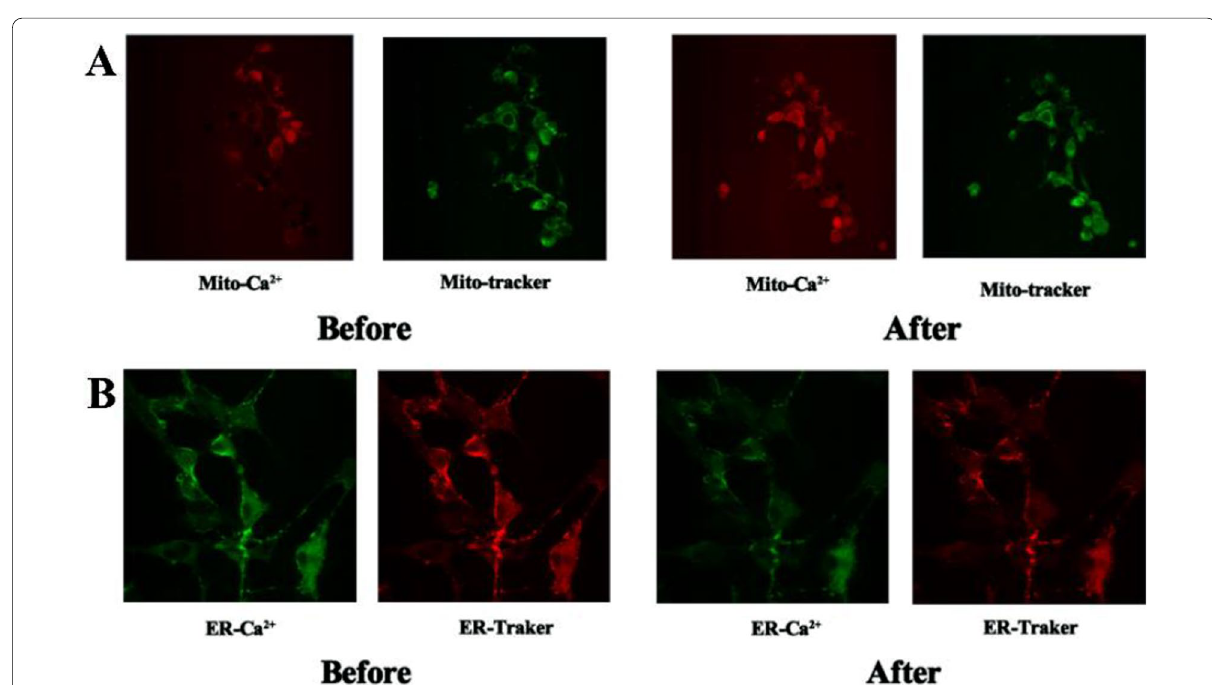
Fig. 6 Representative confocal images of MC3T3-E1 cells. A MC3T3-E1 cells were double-loaded with ER tracker (red) and Mag-fluo4/AM (green) to determine ER Ca 2 + levels. B MC3T3-E1 cells were double-loaded with MitoTracker Green and Rhod-2AM (red) to determine mitochondrial Ca 2 + levels. (20 ×